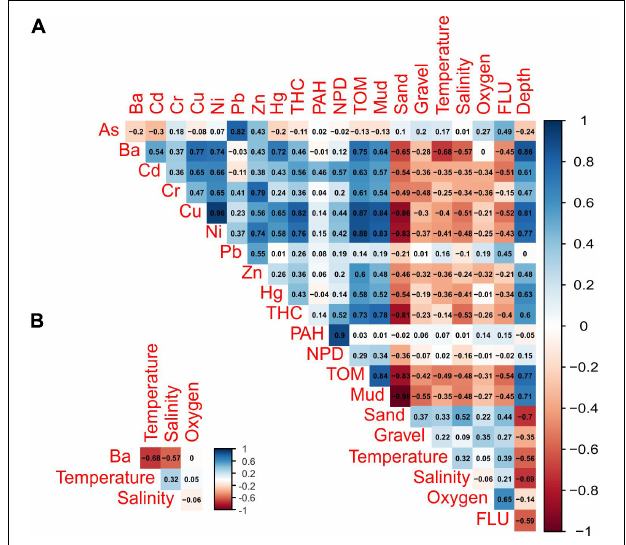
FIGURE 2 | Pearson’s correlation matrix of environmental variables (A) . Only four of the least correlated ( r < 0.70) variables were used in the CCA analysis (B)